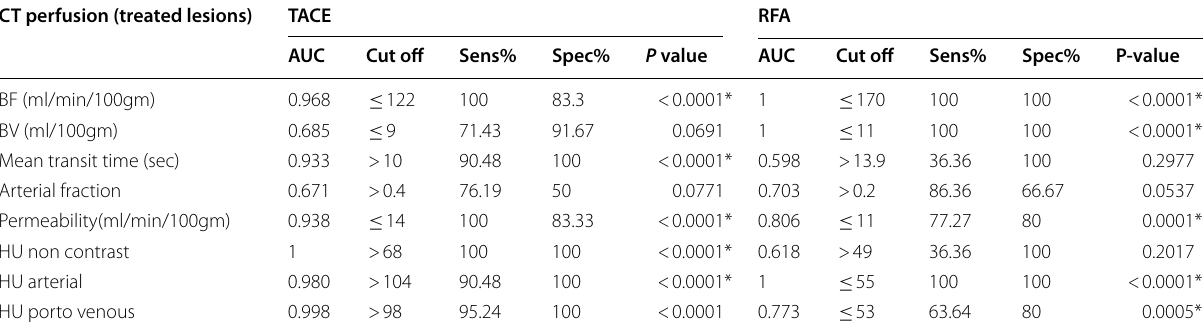
Table 3 Predictive value of CT perfusion for Response in TACE-/RFA-treated lesions by Receiver Operating Characteristic Curve (ROC) CT perfusion (treated